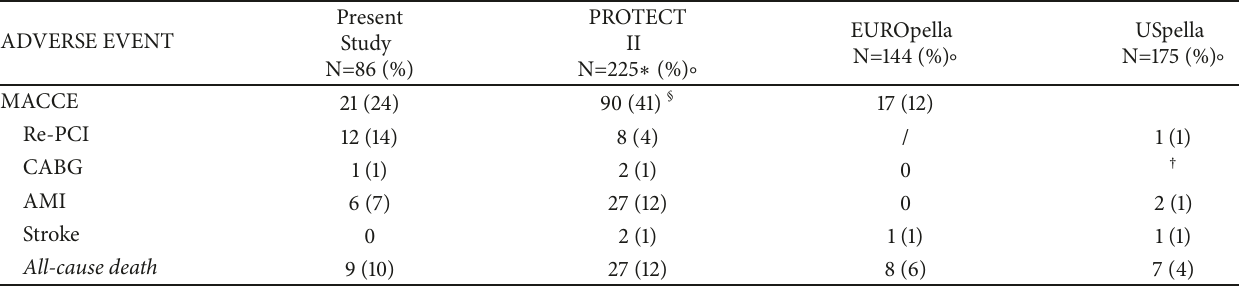
Table 4: Clinical outcome at longest follow-up.